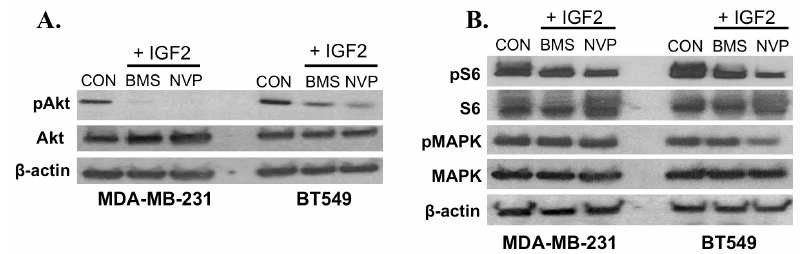
Figure 3. Inhibitory effects of BMS-754807 and NVP-AEW541 on IGF2-induced signaling. ( A ) IGF1R/IR Inhibitors reduce pAKT. TNBC cell cultures were serum starved for 3 h, then incubated with BMS-754807 or NVP-AEW541 for 1 h. IGF2 (100 ng/mL) was added to the serum-free, and